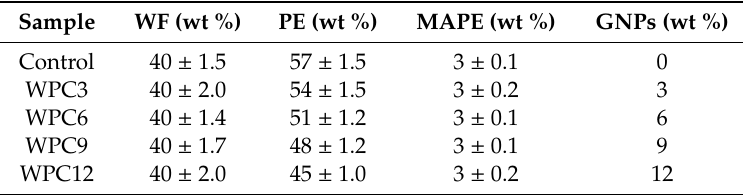
Table 1. Mass fraction of raw materials for wood-plastic